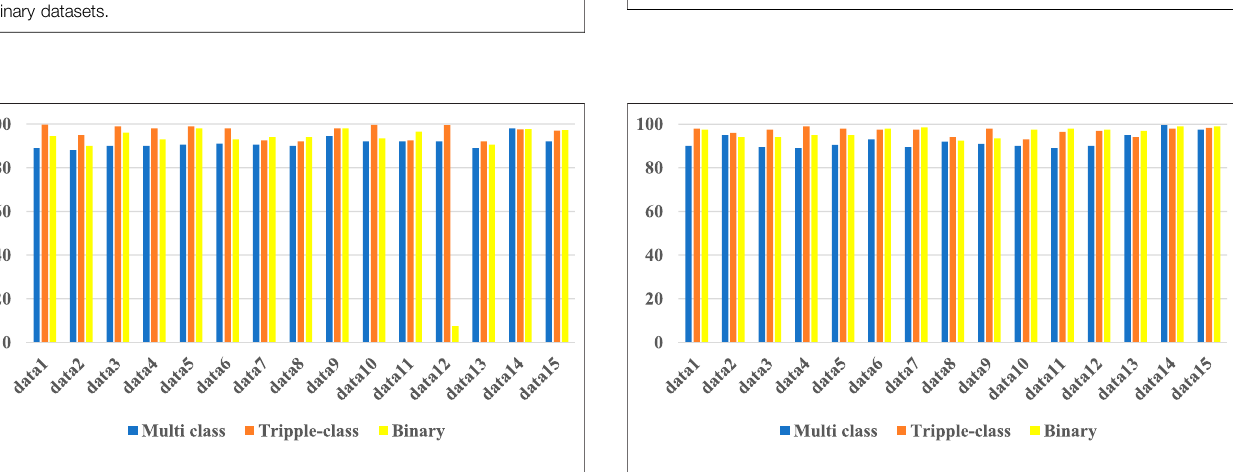
FIGURE 11 | F 1 score across 15 binary, 15 trinary-class, and 15 multiple-class